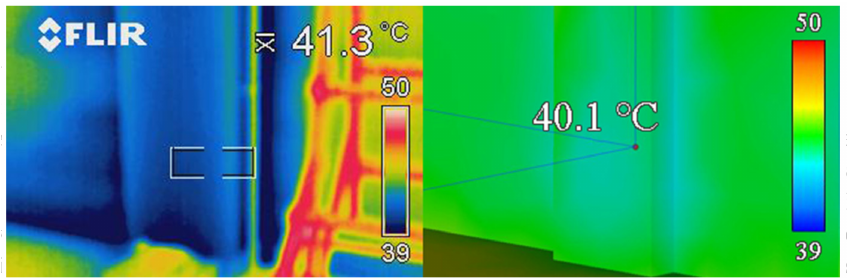
Figure 11. Comparison between data obtained by using the thermal camera and data obtained with CFD analysis at a pillar of the north